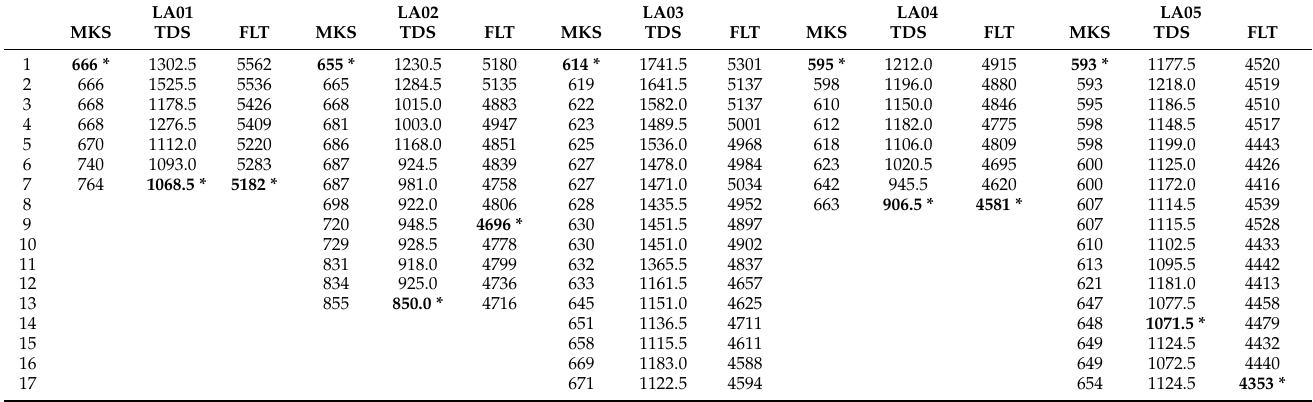
Table A15. Non-dominated solutions obtained by SS/CMOTA for the JSSP instances proposed by